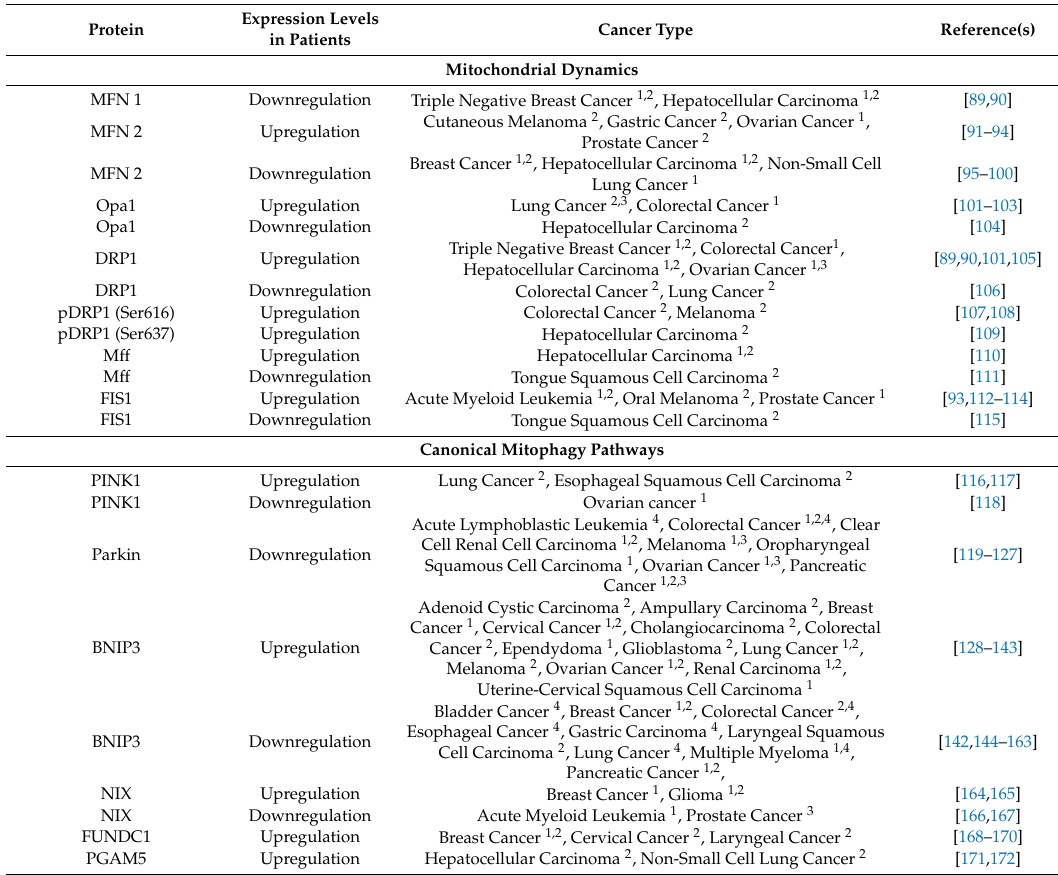
Table 1. Expression levels of mitophagy regulators in samples from cancer patients. The levels of regulation are defined by the correlation of the expression levels with cancer progression and / or poor